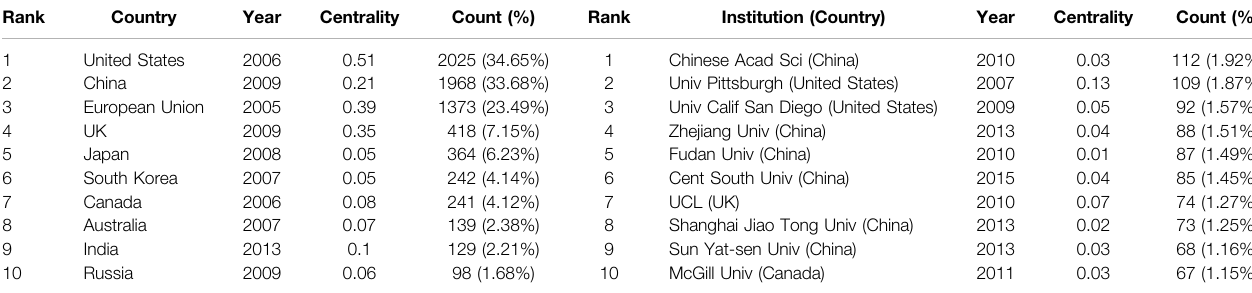
TABLE 1 | Top 10 countries/political entities and institutions contributed to publications on mitophagy. Rank